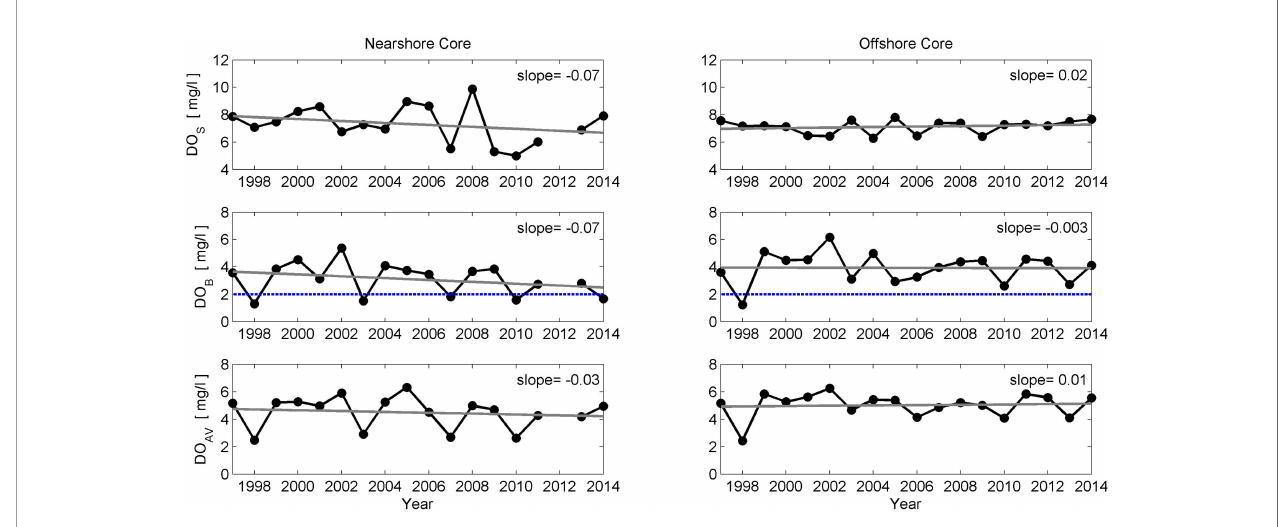
FIGURE 3 | Time series (black curve with dots) and linear trend (gray line) of surface (DO S ), bottom (DO B ), and water column averaged (DO AV ) DO values for “ dual- structure ” low-oxygen areas. The blue dashed line indicates the hypoxia threshold (DO = 2 mg/L). Left panels are averaged values at stations S1 and S2, and right panels are, at stations S3, S4, and S5. Corresponding data of DO S , DO B , and DO AV are listed in Table S4 .